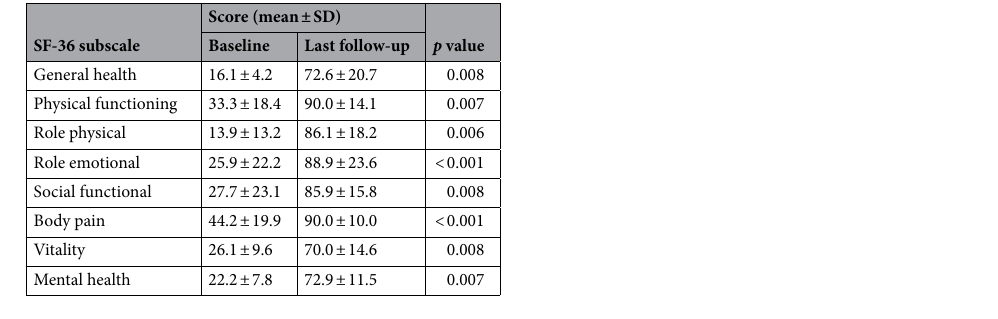
Table 4. The outcomes for 36-item Short-Form General Health Survey. SF-36 The 36-item Short-Form General Health Survey, SD standard